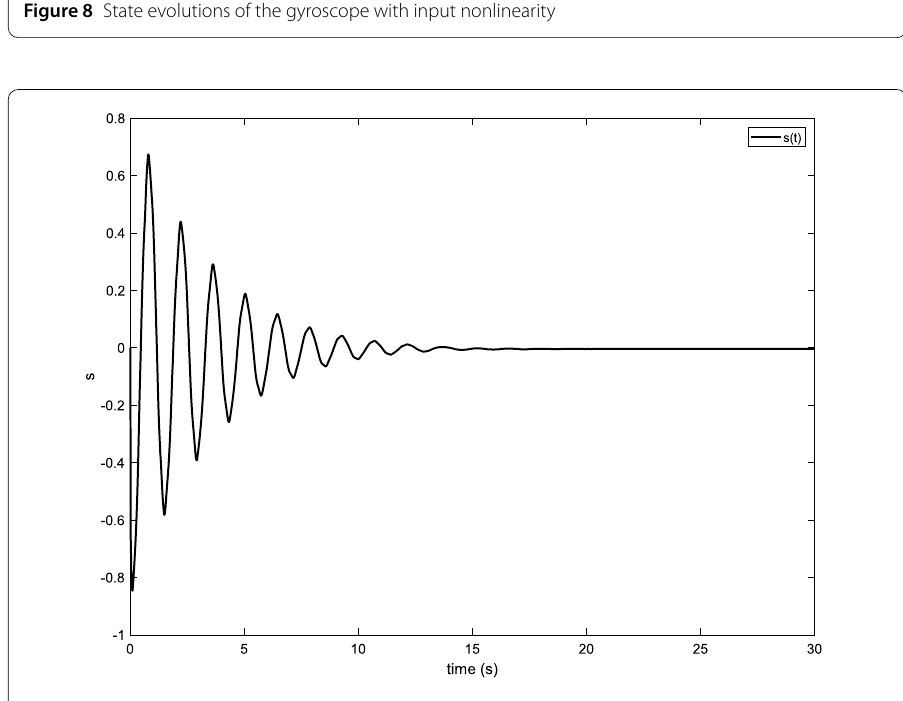
Figure 8 State evolutions of the gyroscope with input nonlinearity